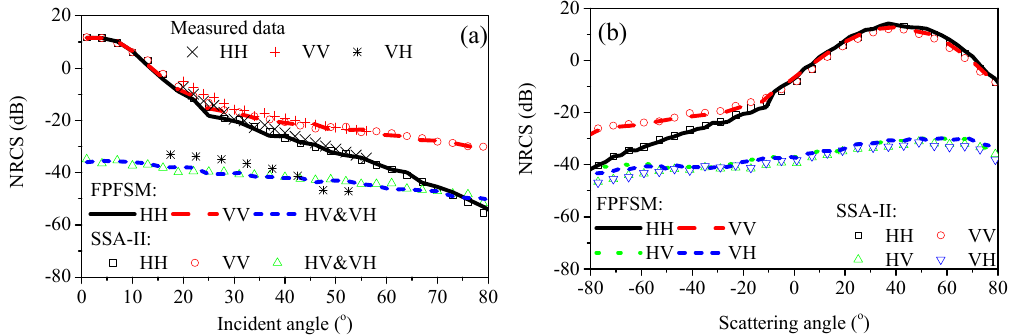
Figure 6. Comparison of the NRCS results calculated by FPFSM and SSA-II at L-band. ( a ) Monostatic configuration; ( b ) Forward–backward configuration. Remote Sens. 2019 , 11 , x FOR PEER REVIEW